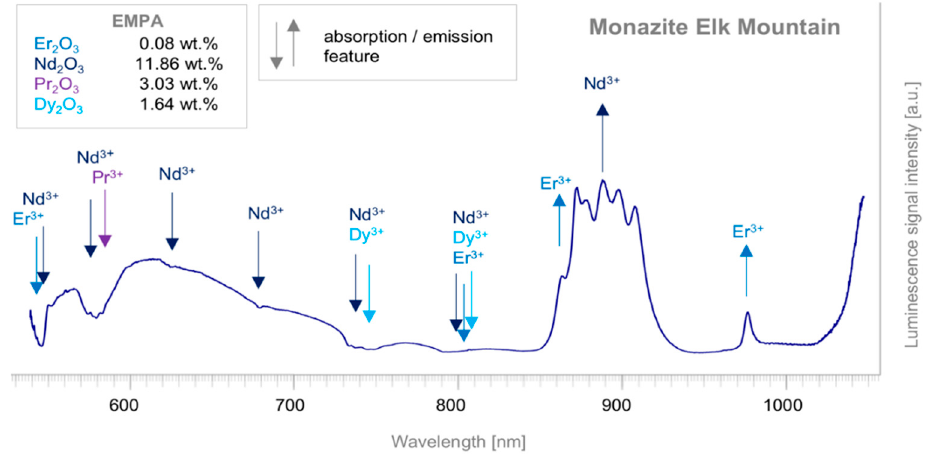
Figure 8. Occurrence of REE absorption features within PL spectra on the example of Monazite Elk Mountain sample. Significant features are labelled with the most probably related REE (also compare Figure 3a). Laser excitation: 532 nm.